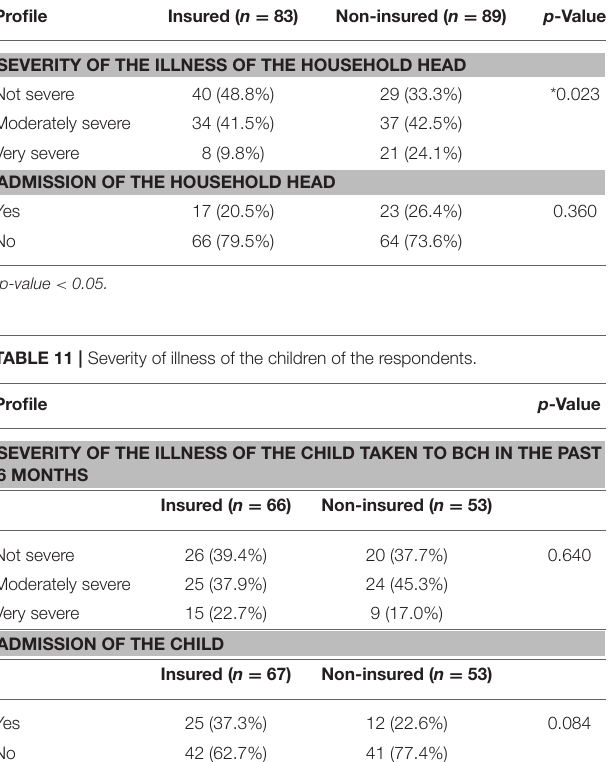
TABLE 10 | Severity of illness among the respondents that visited BCH for self.